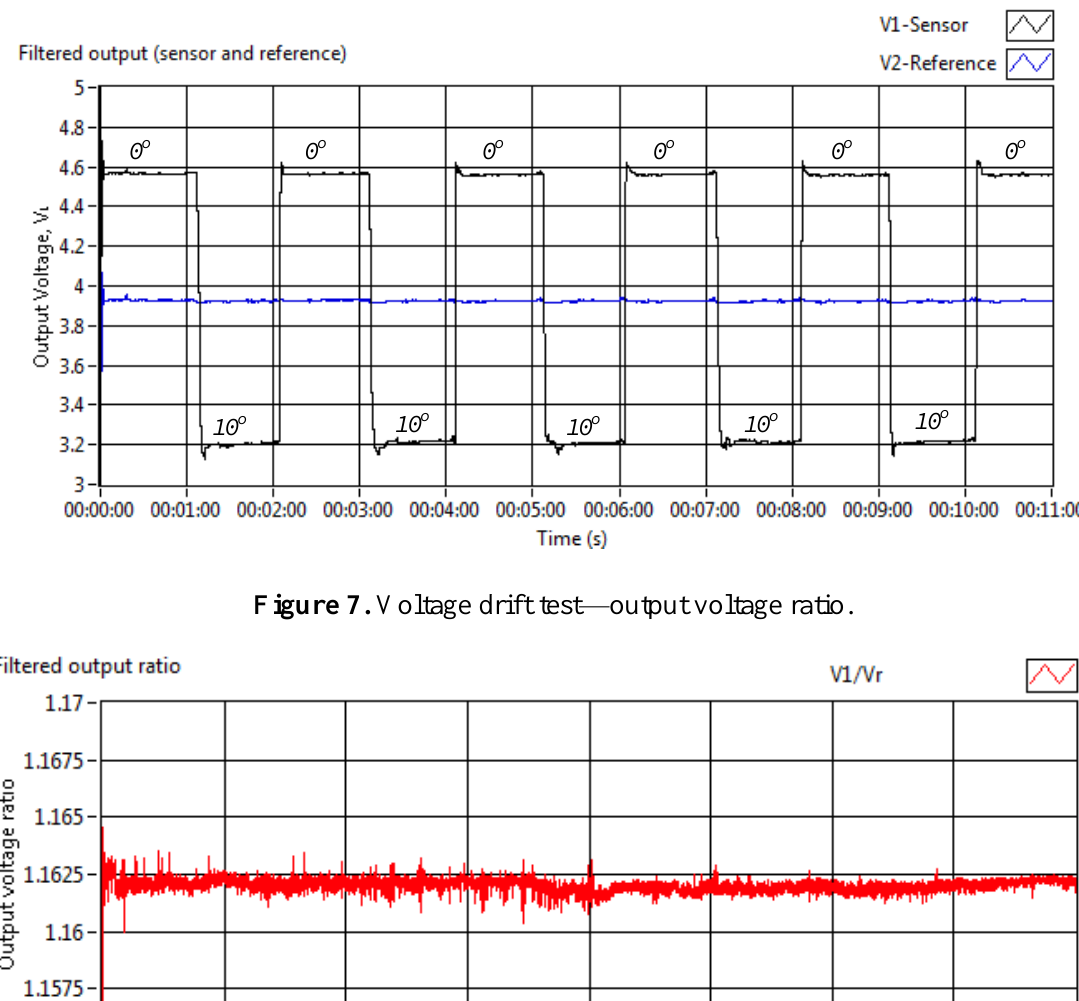
Figure 6. Repeatability test—actual output voltage.